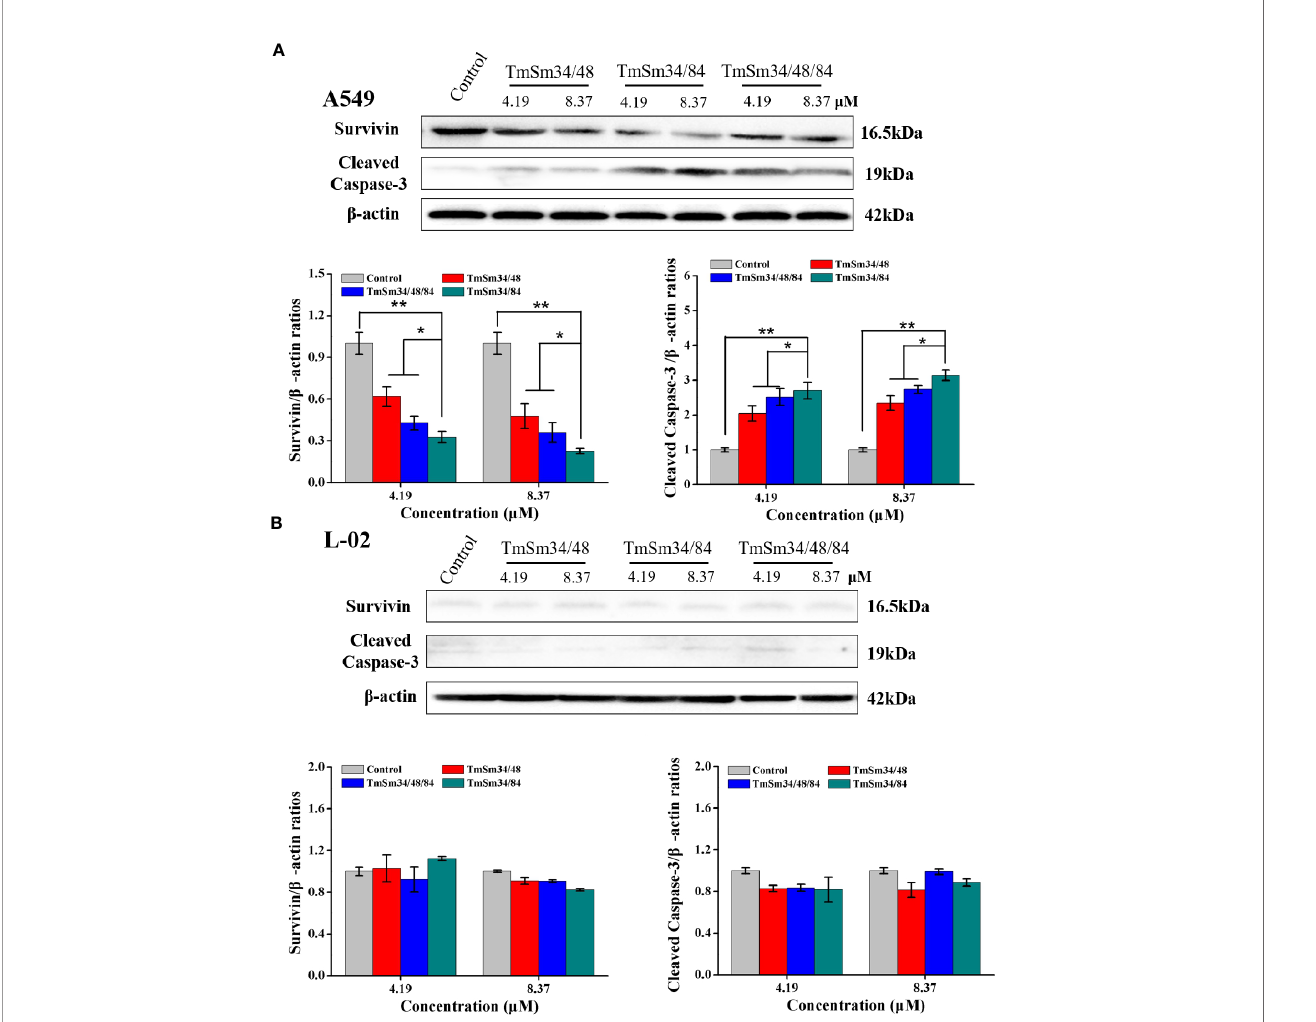
FIGURE 4 | Expression levels of survivin and cleaved caspase-3 in A549 and L-02 cells were determined by Western blot. (A) A549 cells were incubated with different TmSm proteins of the same concentrations gradient (0, 4.19, and 8.37 m M) for 24 h, the expression level of survivin and cleaved caspase-3 was detected by Western blot. (B) L-02 cells were incubated with different TmSm proteins of the same concentrations gradient (0, 4.19, and 8.37 m M) for 24 h, the expression level of survivin and cleaved caspase-3 was detected by Western blot. Data were expressed as mean ± SD ( n = 3). * P < 0.05 and ** P <